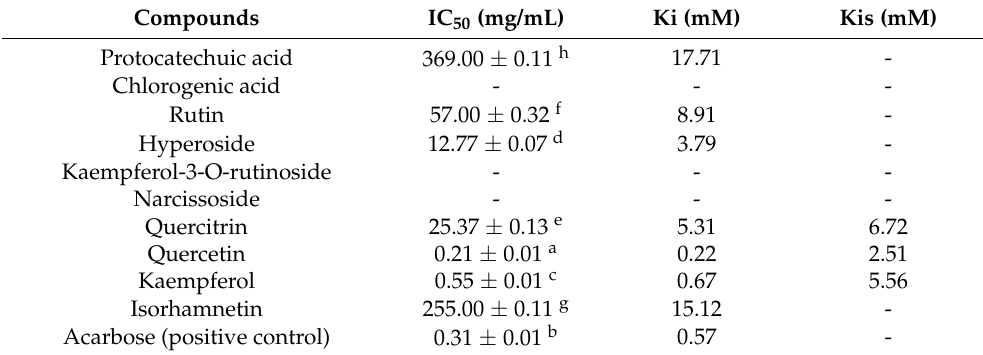
Table 1. The values of IC 50 and inhibitory constants of polyphenols in Flos sophorae immaturus extract on α -glucosidase inhibitory activity. Different letters in the table indicate that the IC 50 values are significantly different ( p < 0.05). Compounds IC 50 (mg/mL) Ki (mM) Kis